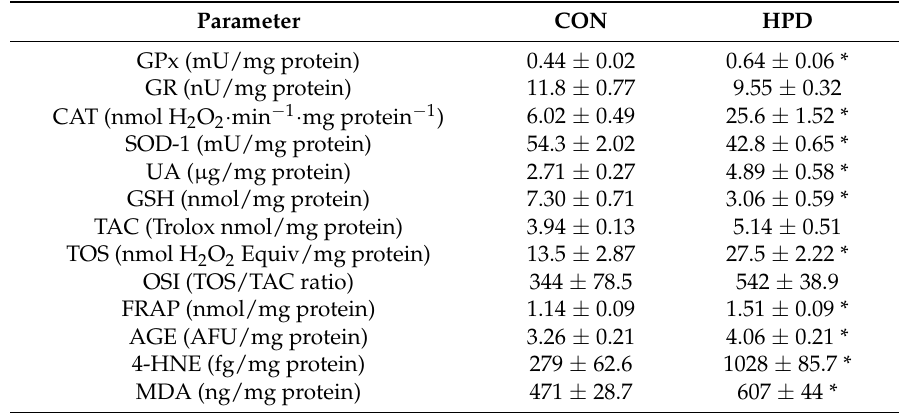
Table 2. Effect of 8-week HPD on enzymatic and non-enzymatic antioxidants, total antioxidant/oxidant status, and oxidative damage products in rat